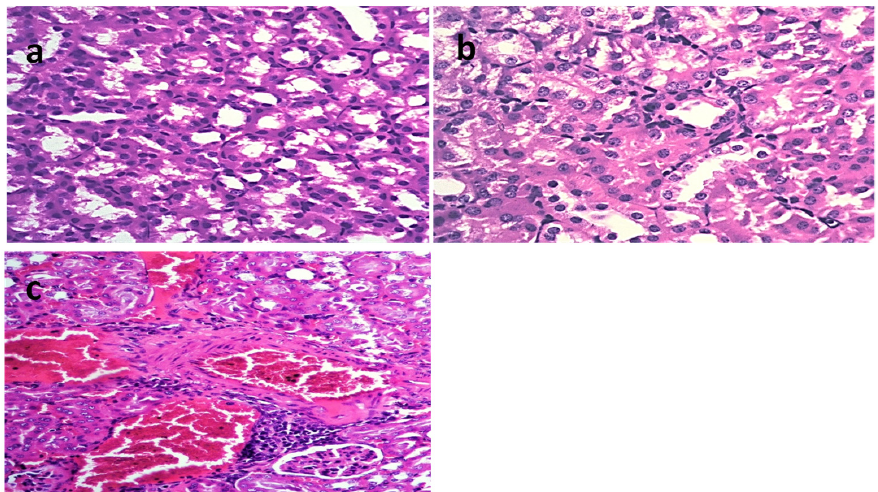
Figure 6. Histological sections of kidneys stained with H&E and scoring of renal lesions in a model of mice infected with E. coli O111. ( a ) Mice infected with E. coli O111 (X = 200), ( b ) mice infected with E. coli O111 and then treated with gentamycin (GEN) (X = 200), and ( c ) mice infected with E. coli O111 and then treated with luteolin 4 ′‐ neohesperidoside (L4N) (X = 200). Table 6. Scoring of renal lesions. For the quantification of bacterial shedding, the bacteria in the feces were